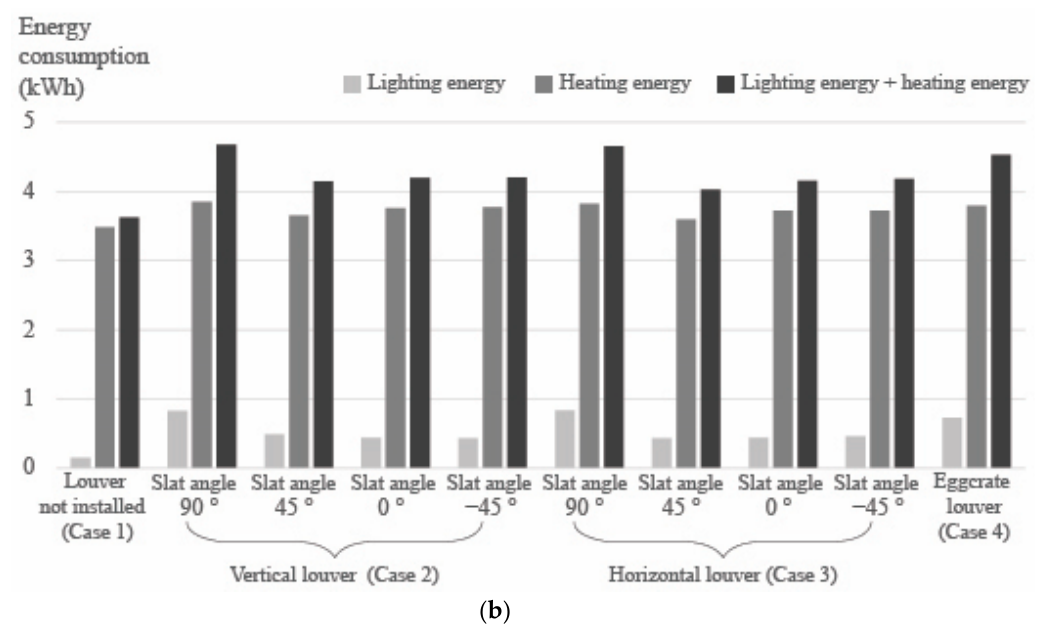
Figure 12. Analysis of energy consumption in Cases 1, 2, 3, and 4: ( a ) summer and ( b ) winter .